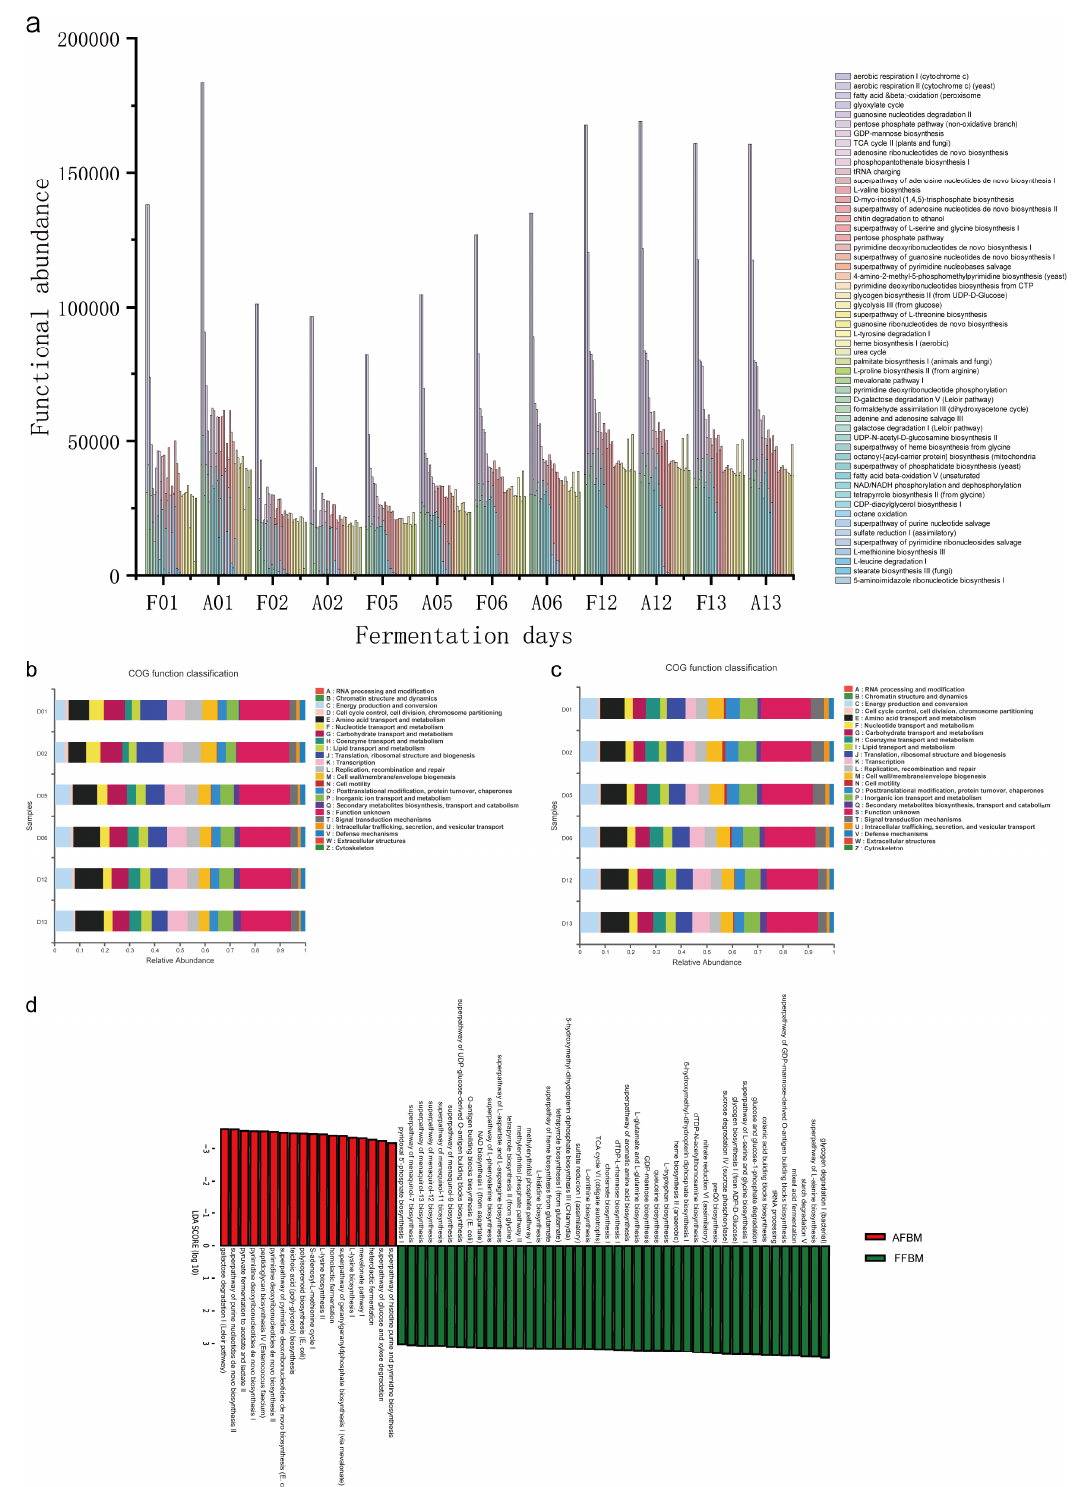
Figure 5. Functional abundance of FFFM and AFFM ( a ). In the horizontal coordinates, F represents FFFM, A represents AFFM, and function is expressed by the relative abundance of metabolic path- ways. Clusters of orthologous groups functional classification of FFBM ( b ) and AFBM ( c ). Functional differences between FFBM and AFBM ( d ). Red represents the differential metabolic pathways in AFBM, green represents the differential metabolic pathways in FFBM. (Function prediction based on MetaCyc